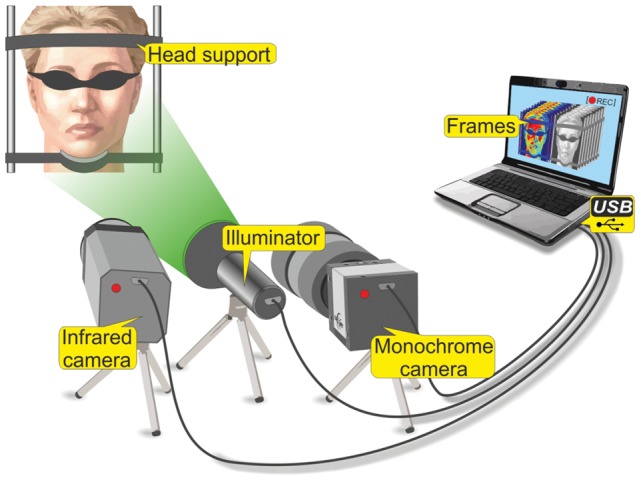
The experimental setup for recording of the blood perfusion in the facial area.